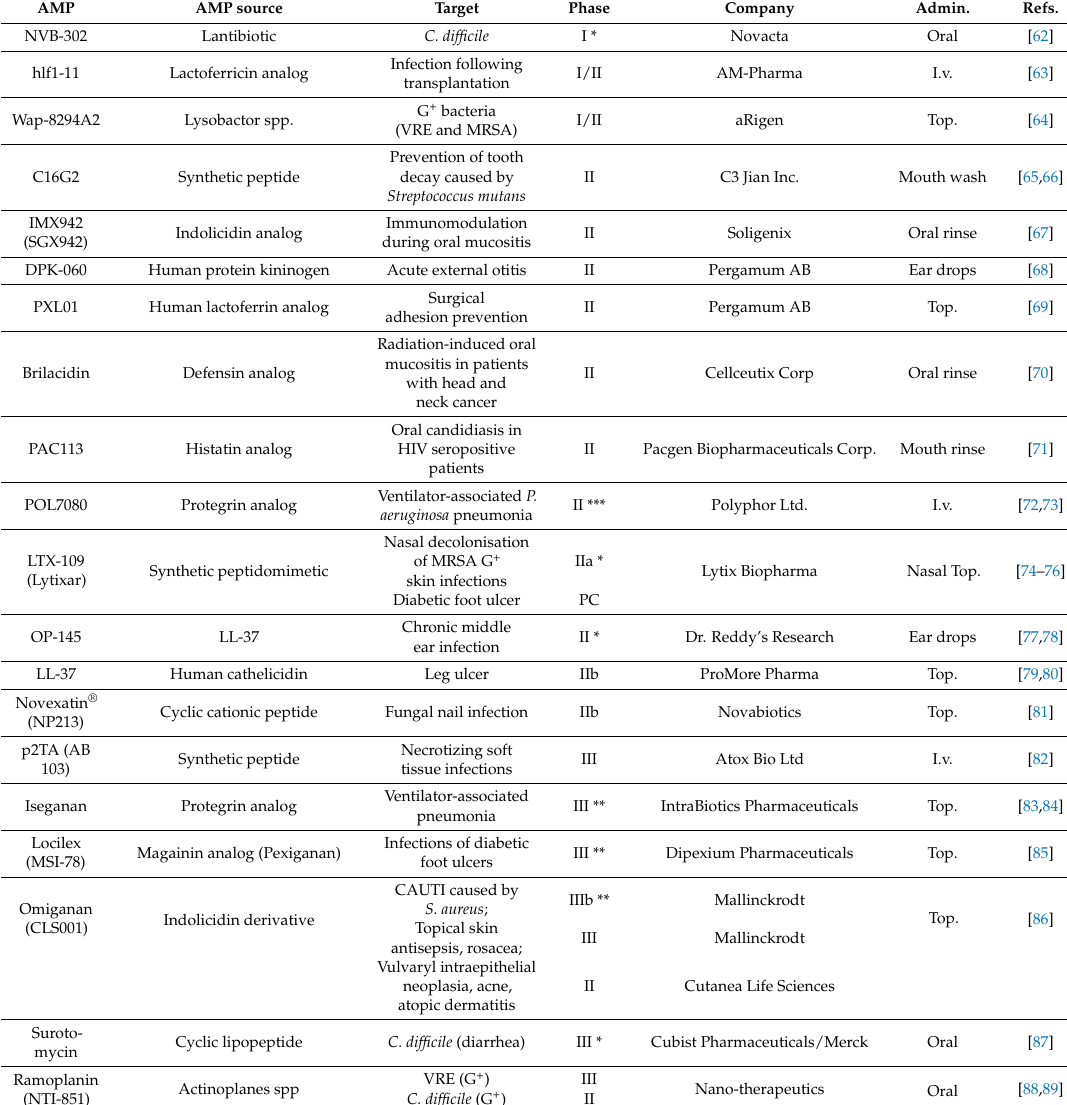
Table 1. AMPs in clinical trials (Phase I–III).